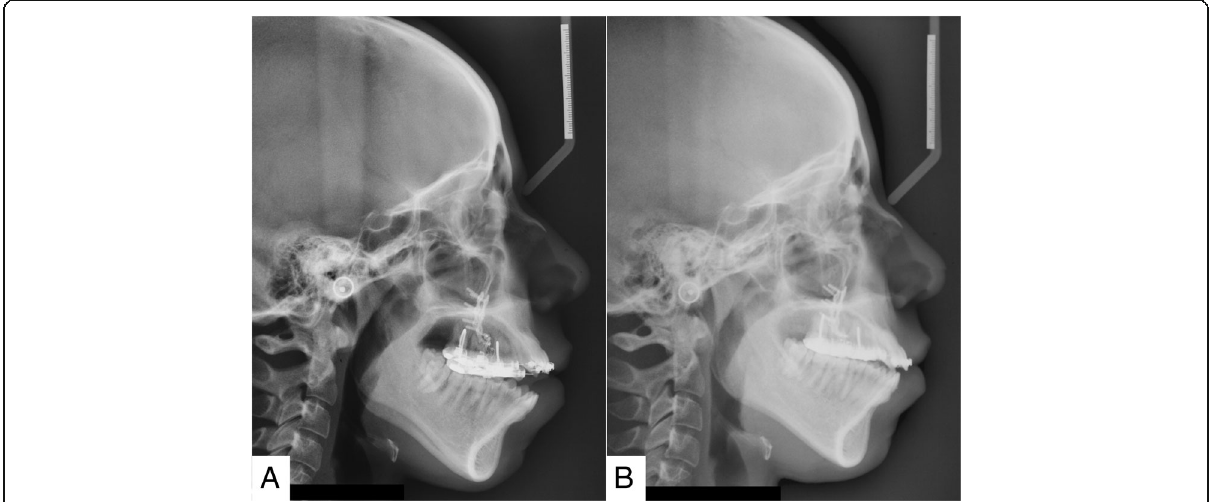
Fig. 2 Lateral cephalometric radiographs of a subject: a before and b after maxillary posterior teeth